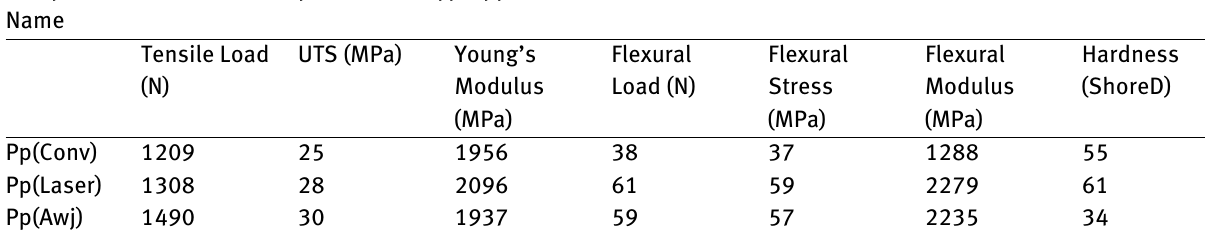
Table 1: Mechanical test results of Polypropylene SRC Laminate